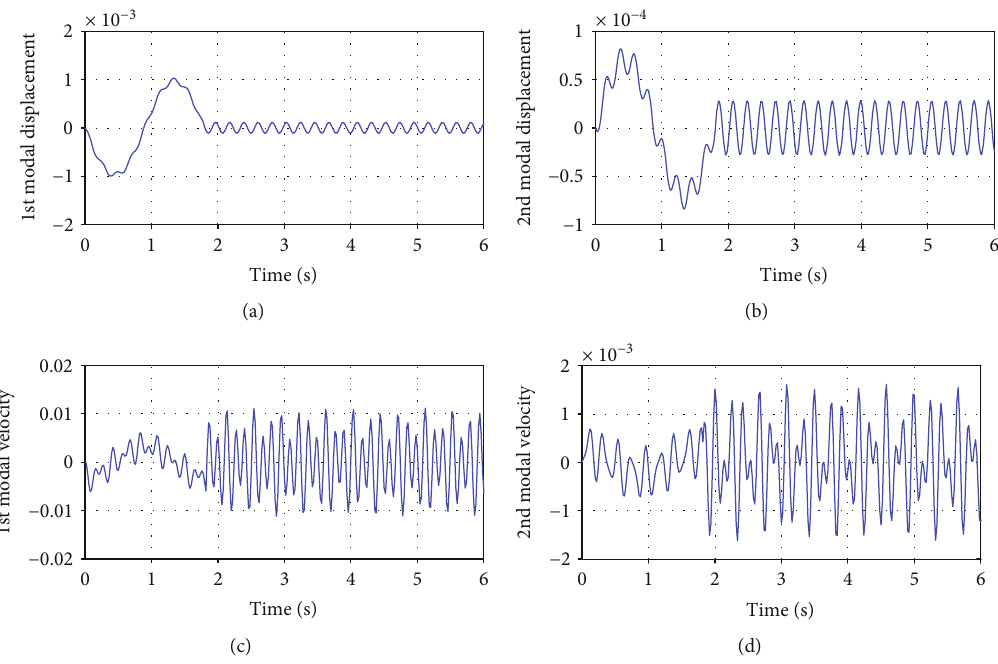
δ _ η i at the working point ð